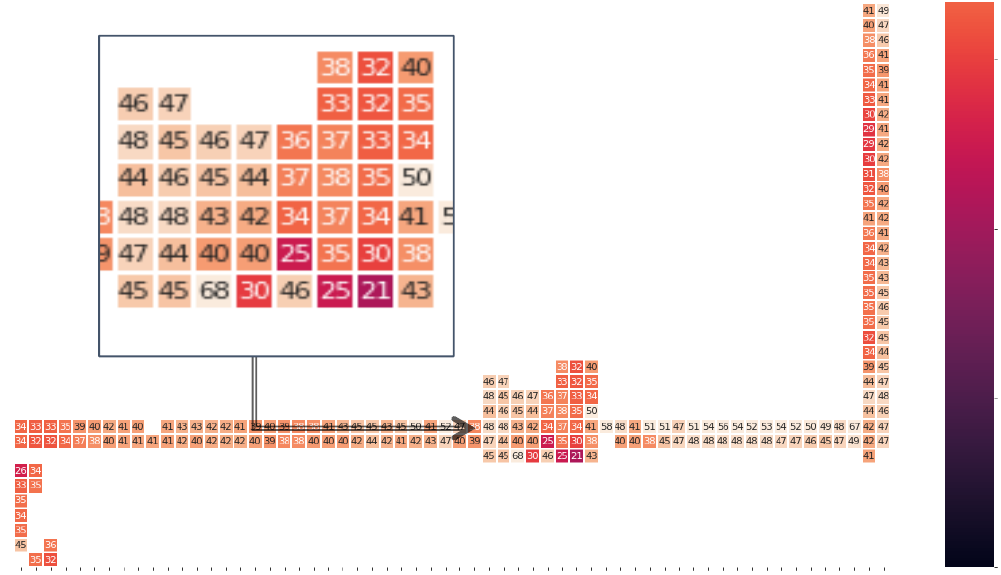
Figure 5. Heatmap of the magnitude of the magnetic field in each place in the building.